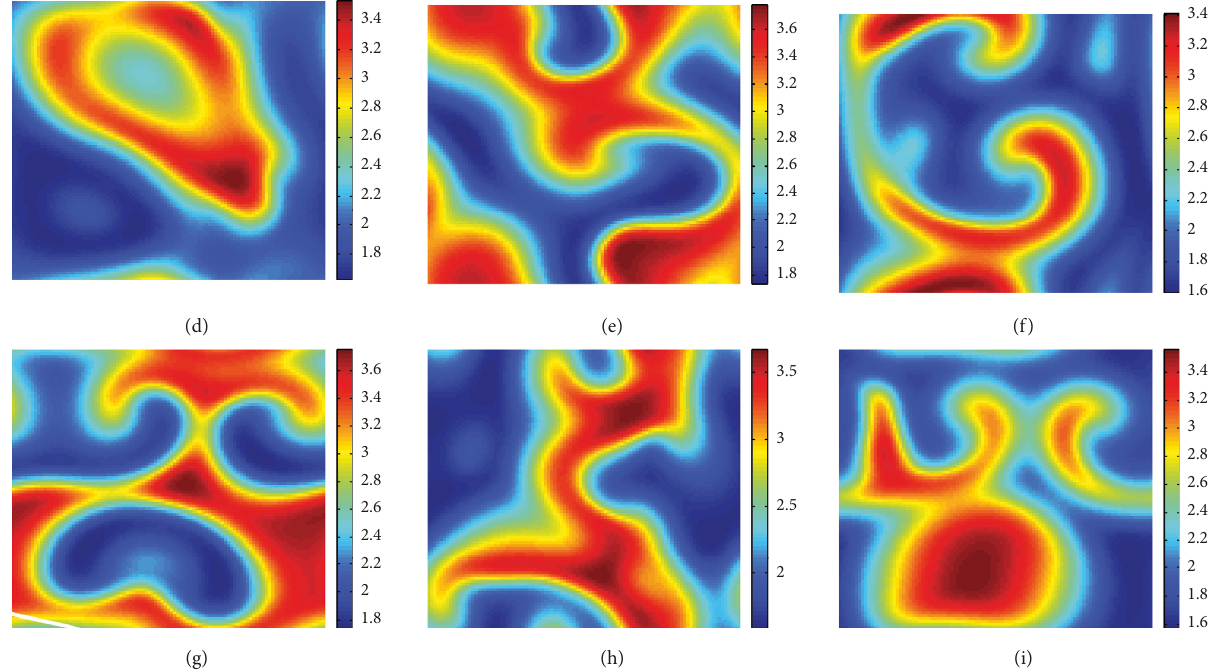
Figure 5: The process of forming cloud-like patterns over time with a time delay of 3. Parameter values: I � 1 . 6, a � 0 . 5, b � 0 . 8, α � 0 . 7, � 0 . 2, d � 0 . 2, q � 0 . 01, τ � 3, and ε � 0 . 001. (a) t � 0; (b) t � 500; (c) t � 2500; (d) t � 5000; (e) t � 7500; (f) t � 10000; (g) m � 0 . 45, d 1 2 t � 12500; (h) t � 15000; (i) t � 20000.